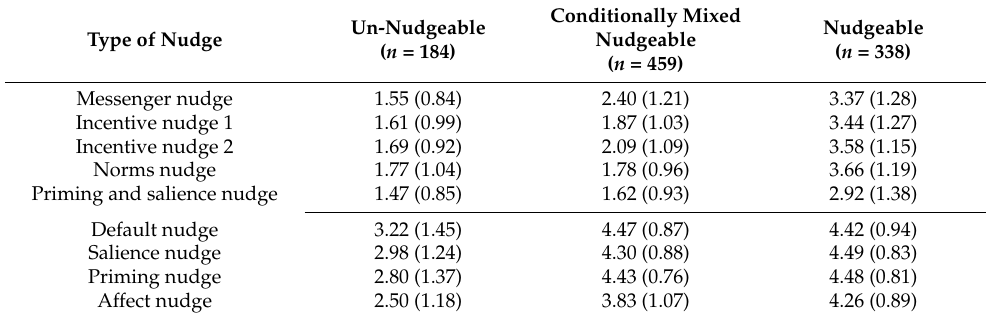
Table 5. Descriptive statistics for the acceptance of the nudge types per